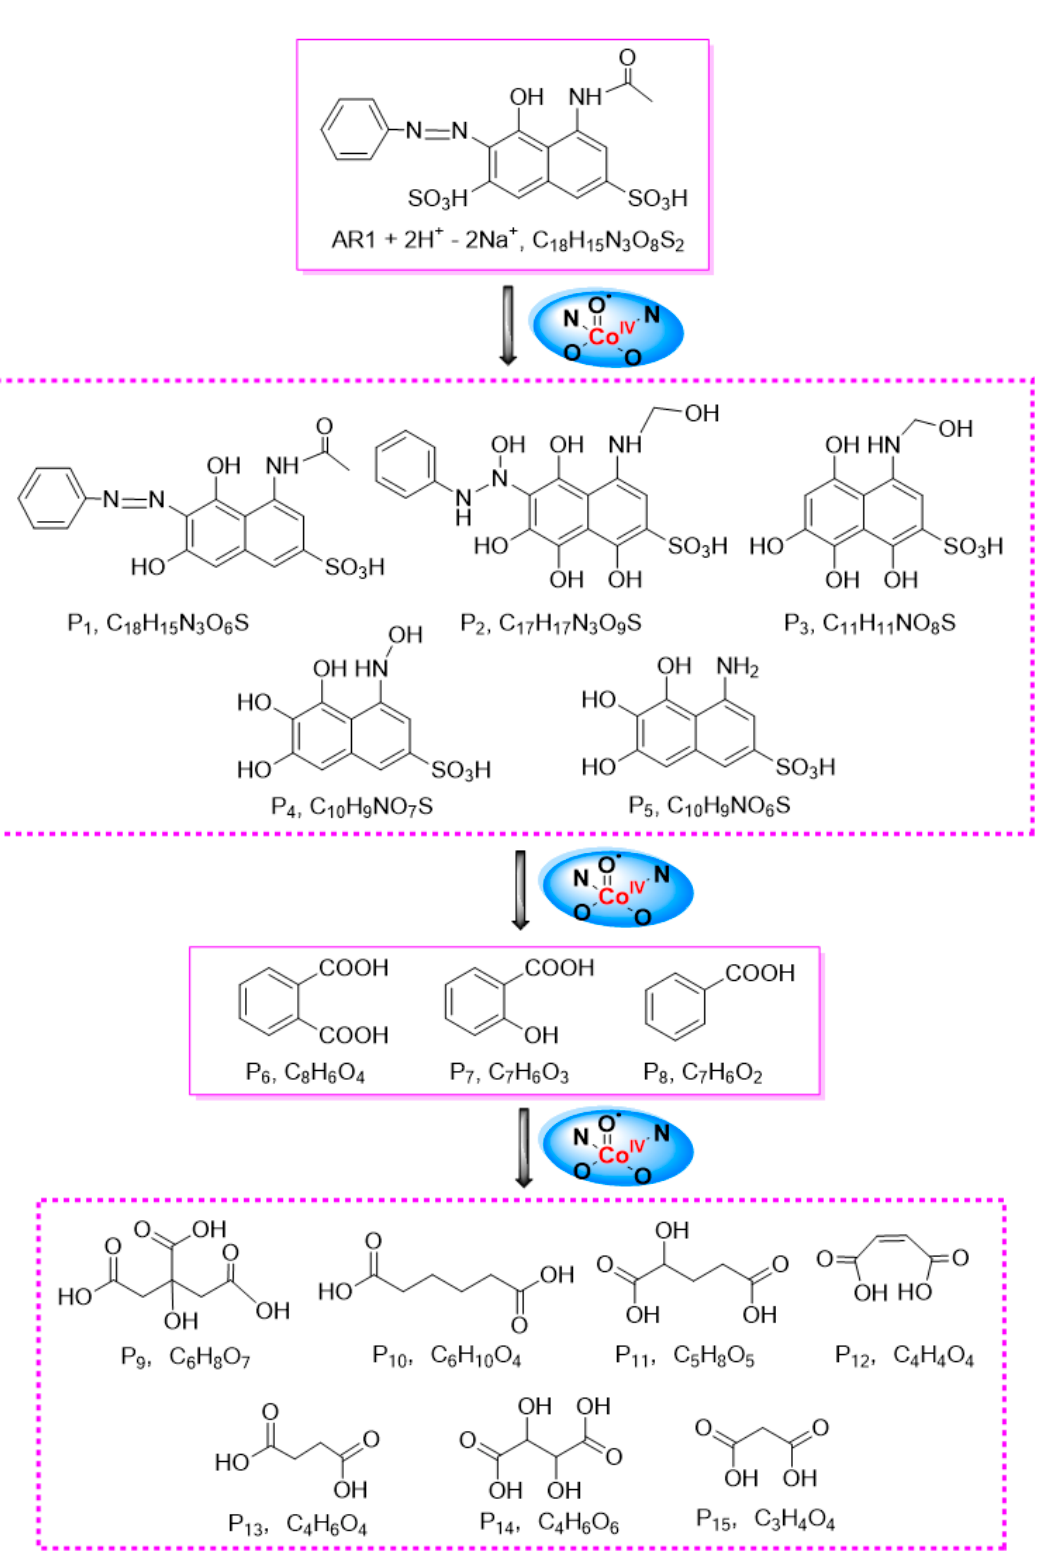
Figure 7. Possible detoxification pathway for the catalytic oxidation of AR1.